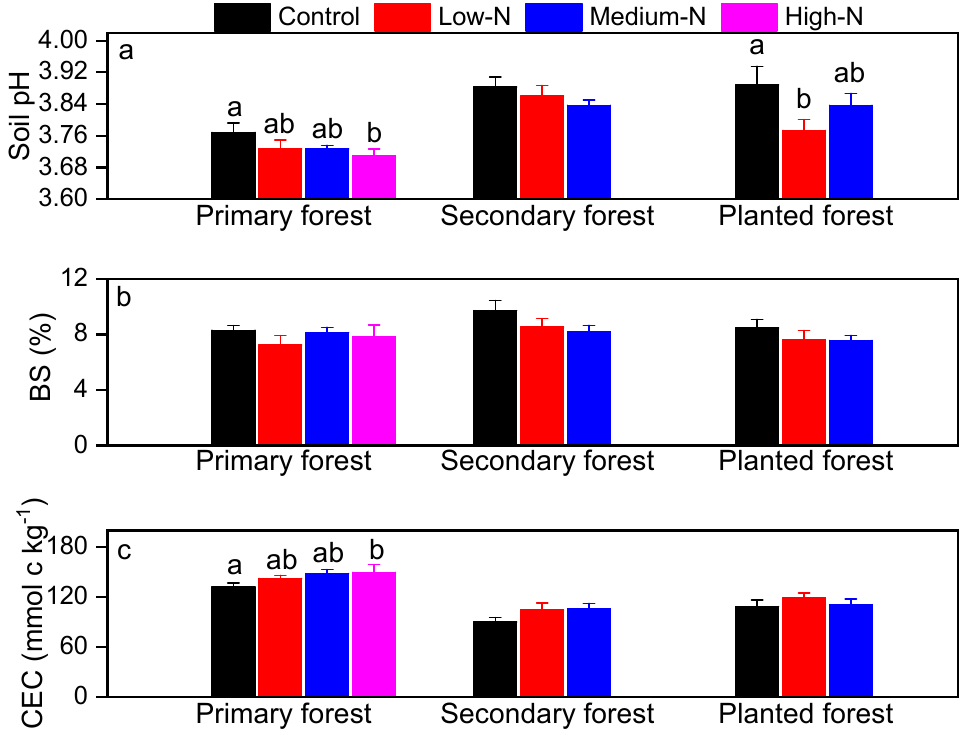
Figure 5. Soil pH ( a ), base saturation (BS, %, b ), cation exchange capacity (CEC, c ) in the primary forest, the secondary forest, and the planted forest in southern China after 8 years of N additions. Different lowercase letters indicate significant differences among treatments ( p < 0.05). Error bars show SE (n = 3).